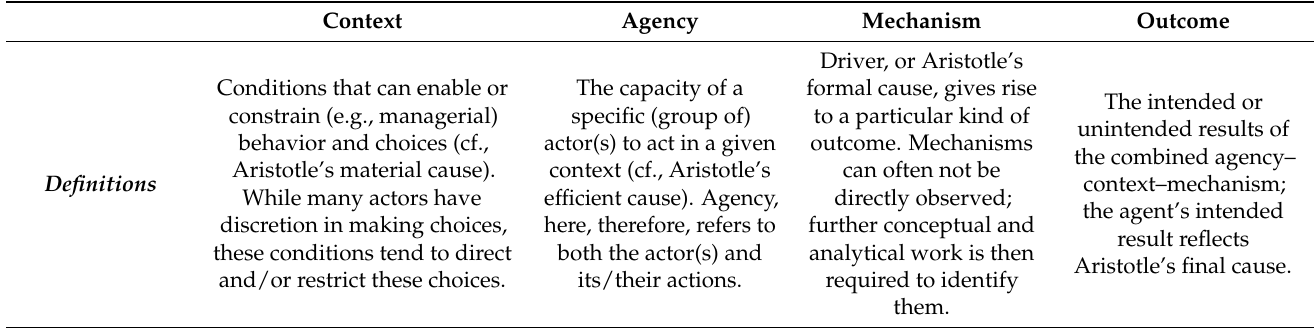
Table 1. The context–agency–mechanism–outcome (CAMO) format,